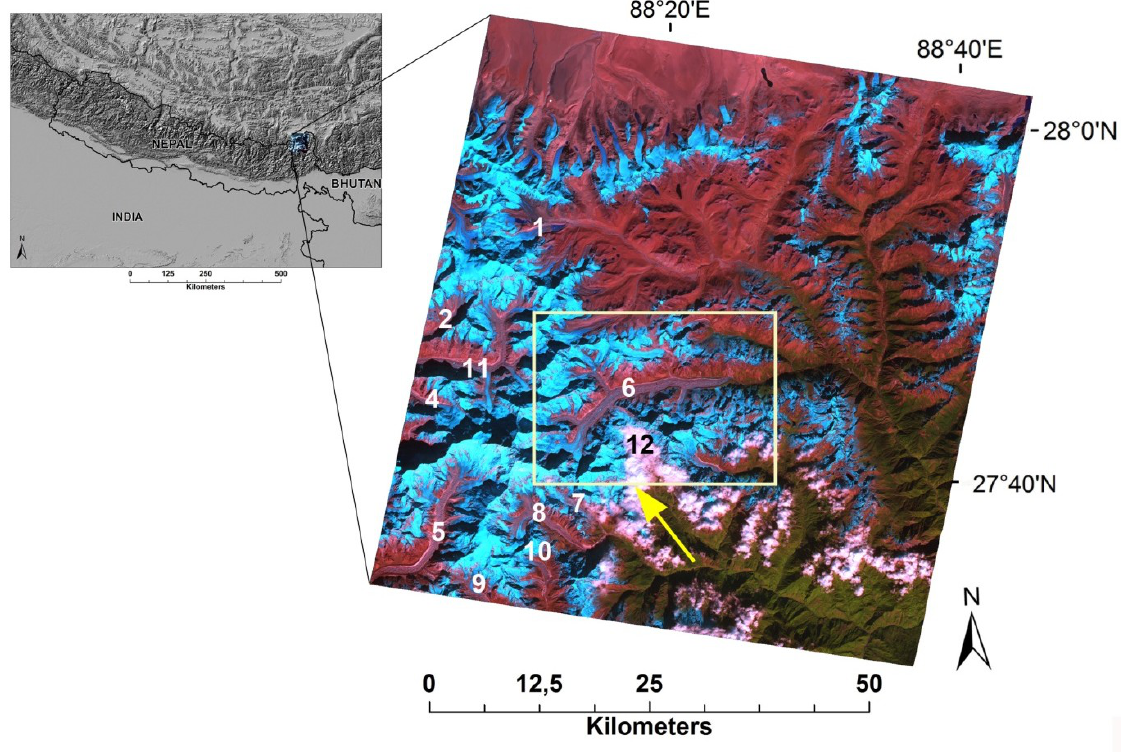
Figure 1. Location map of the study area (the Sikkim Himalaya). The figure on the right is a false color composite (FCC) ASTER 543. In this composite, glacier ice is shown as turquoise, vegetation is green, clouds are white and bare land is red. The yellow arrow points to the clouds obstructing the view of glaciers on the southern part of the image. Also shown is the subset area on which texture analysis was performed (Section 2.4). Numbers refer to